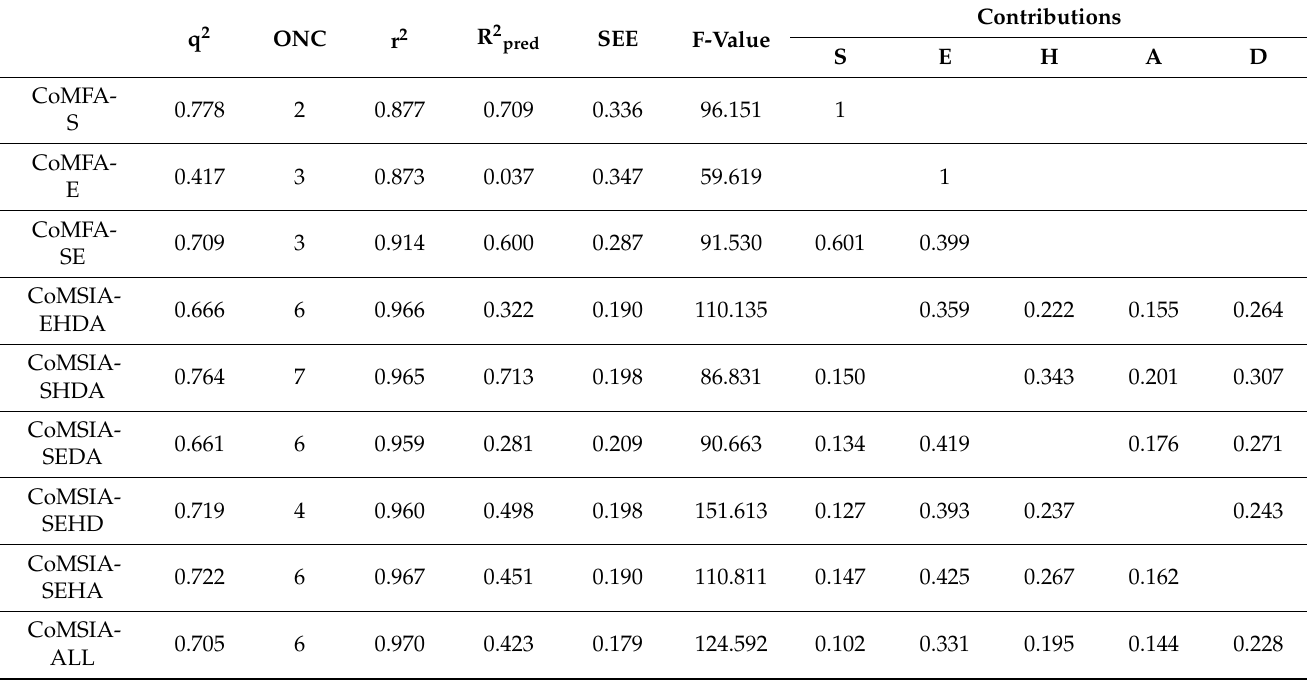
Table 1. Statistical parameters of CoMFA and CoMSIA model. (S, steric; E, electrostatic; H, hydropho- bic; A, H-bond acceptor; D, H-bond